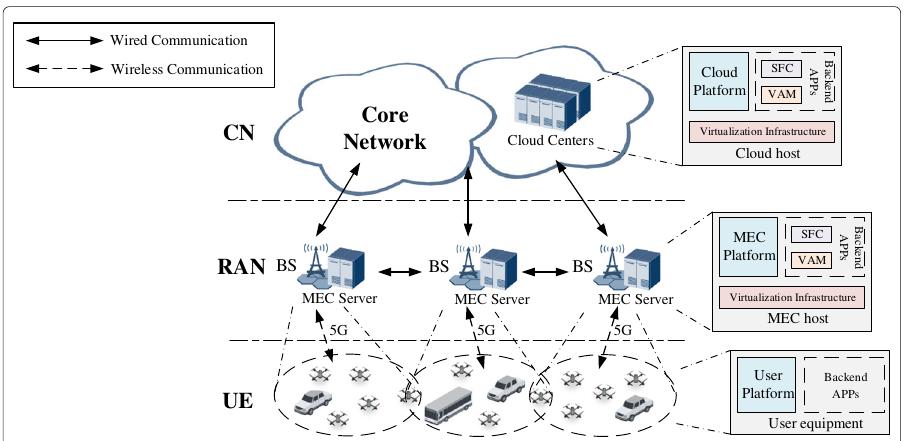
Fig.1 The proposed MEC architecture. This is the proposed multi-access edge computing (MEC) architecture. In the architecture, MEC servers and BSs are integrated within the radio access network (RAN) and deployed on the user plane interface, i.e., between the core network (CN) and user equipment (UE). Each base station is equipped with a MEC server, which is also regarded as an independent network element complementing the existing cellular network without impacting the connectivity of other interfaces. These MEC servers are connected to corresponding base stations via dedicated reliable links to provide particular services for diverse end-user of such several nearby cells. MEC servers and centralized cloud centers are connected through the Internet backbone and share information with each other, so as to work in a cooperative